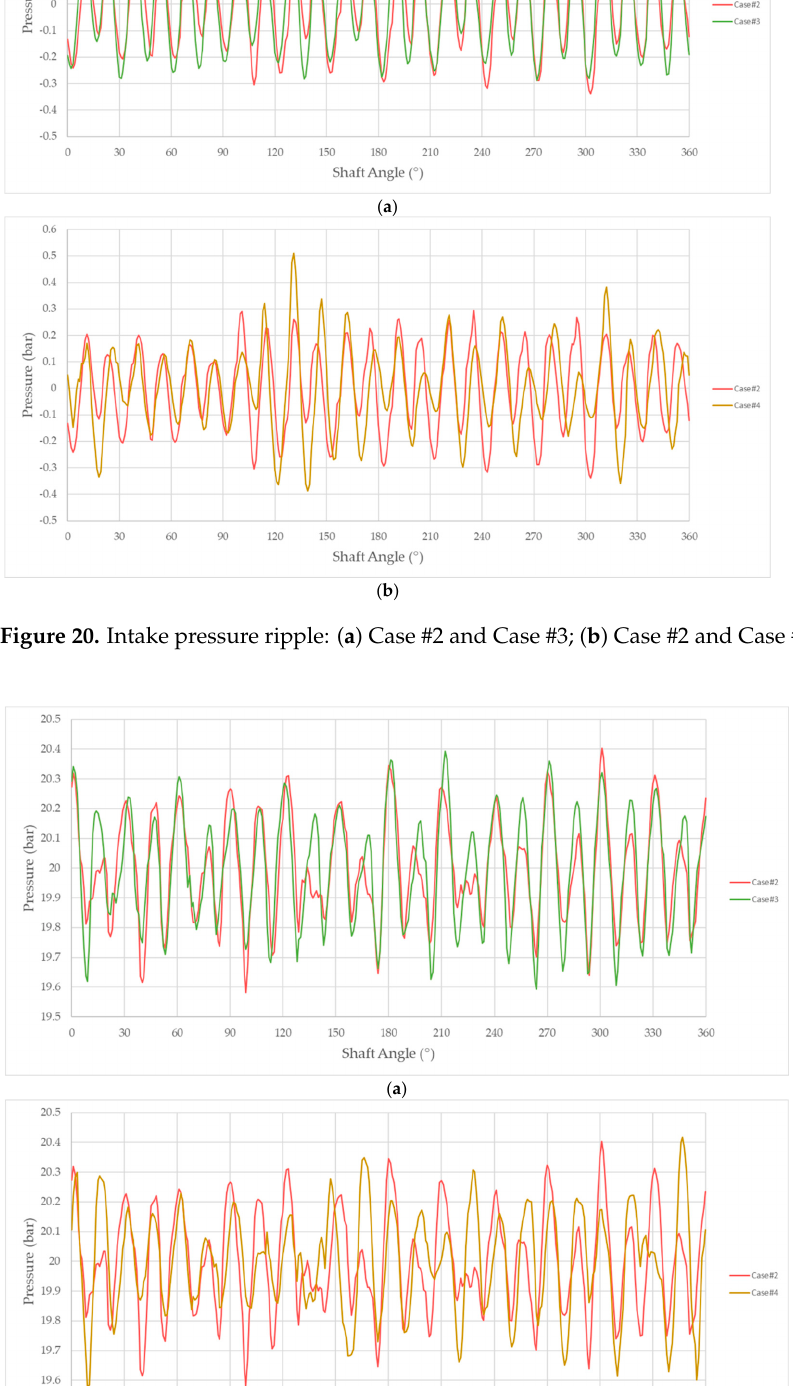
Figure 22. Pressure within a displacement chamber of the pump during an entire revolution of the driving shaft for Case #2, Case #3, and Case #4.